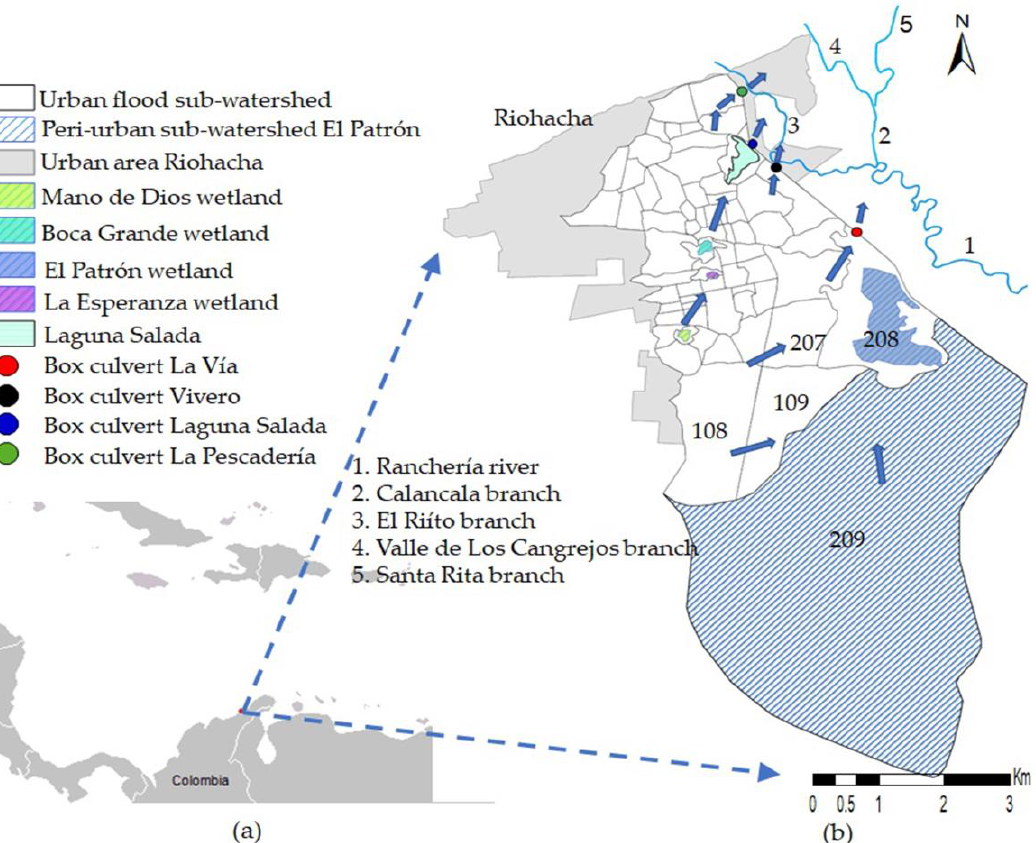
Figure 1. Location and details of the study area. ( a ) site of Colombia in South America; ( b ), delim- itation and key details of the flood sub-watershed within the city of Riohacha, department of La Guajira